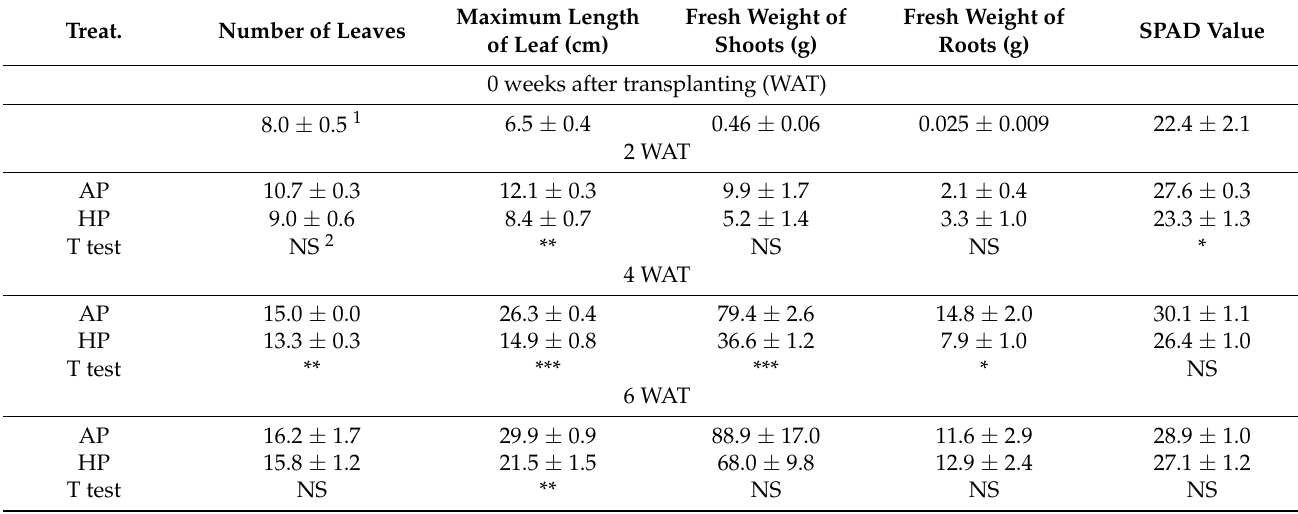
Table 1. Growth of lettuce plants in aquaponics (AP) and hydroponics (HP) in Exp. 1. Treat.